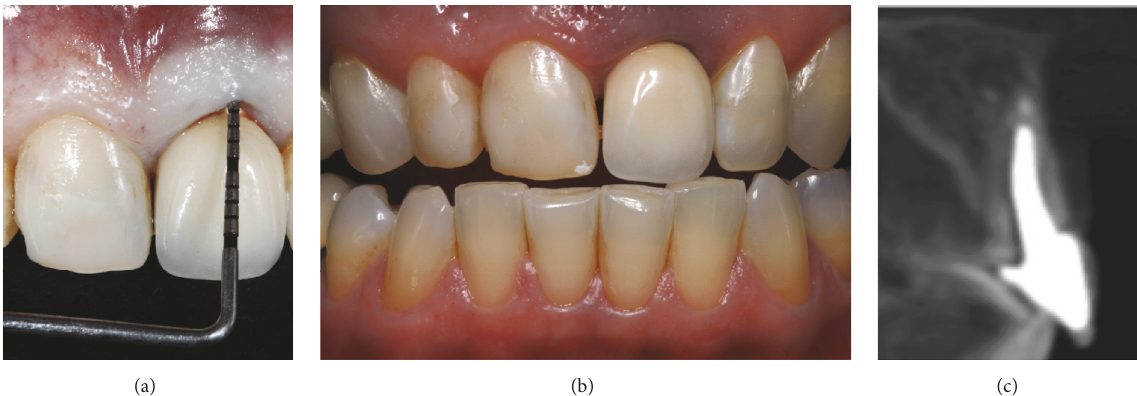
Figure 1: An oblique fracture occurred in tooth 21 due to occlusal trauma. Clinically the patient presented a deep periodontal pocket in tooth 21 (a) thin biotype and shorter clinical crowns in teeth 13 and 12 (b). The buccal bone wall loss and periapical lesion were observed in the CBCT (c).